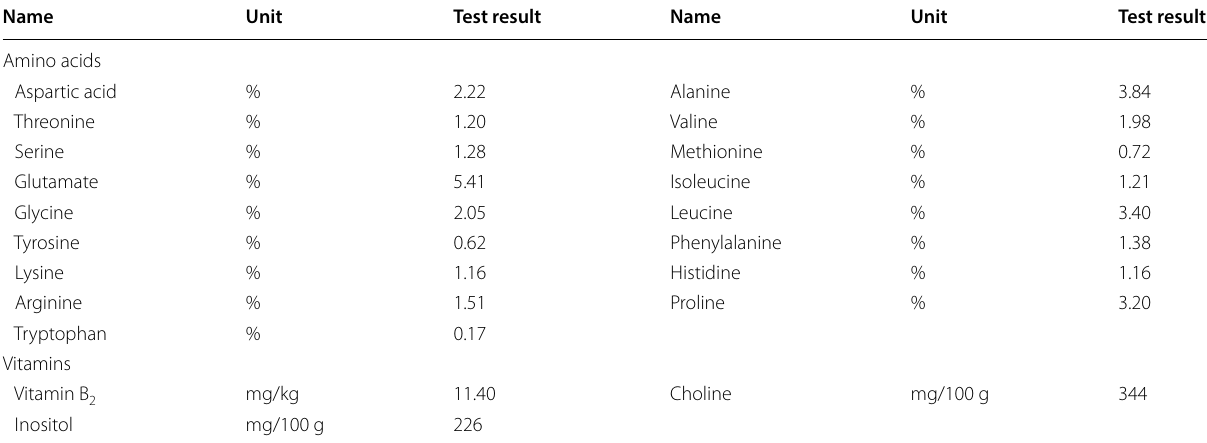
Table 1 Nutritional substances contained in the corn steep